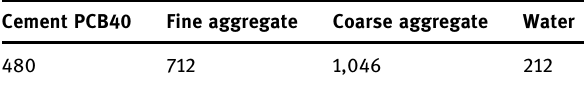
Figure 1: Layout of test beams.